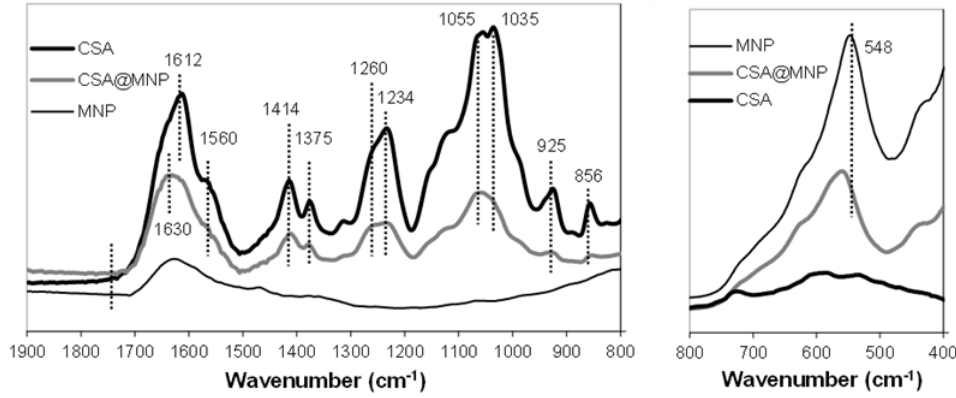
Figure 3. FTIR-ATR spectra (absorbance is given in arbitrary units) of CSA, magnetite (MNP), and CSA-coated magnetite (CSA@MNP) in the 800 − 1900 cm − 1 (left side) and in the 400 − 800 cm − 1 (right side) range. Samples were dried on the diamond crystal from solution/dispersions at pH ~6.3. Table 1. Characteristic IR bands and their shifts (cm − 1 ) due to the CSA-adsorption on magnetite nanoparticles at pH ~6.3 and 10 mM